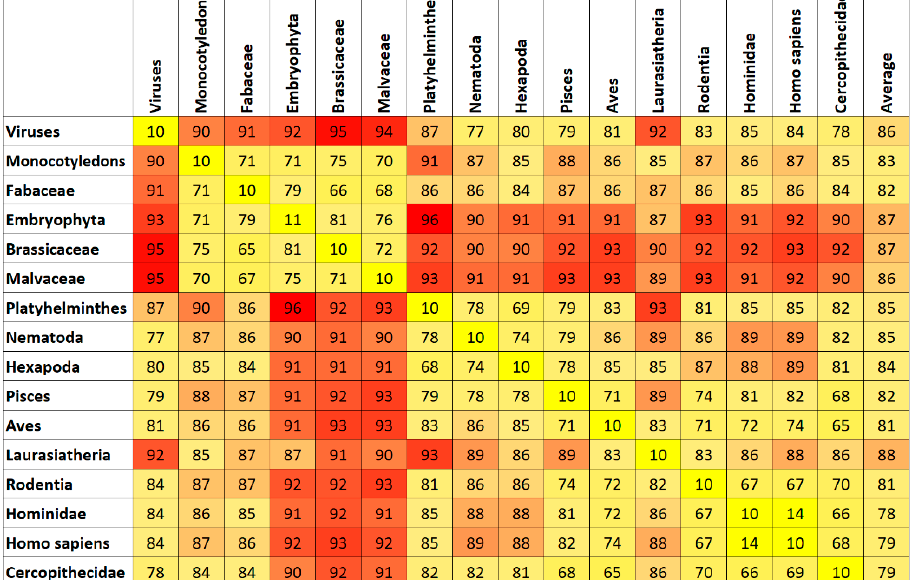
Figure 7. Most published features describing a pre-miRNA (about 700), excluding the features that only rely on sequence information. The results presented in the figure stem from models trained with the top 100 features selected from previously published features. Yellow shades indicate better performance for k-mer first–last distance, while red shades indicate higher average classification accuracy for k-mers.